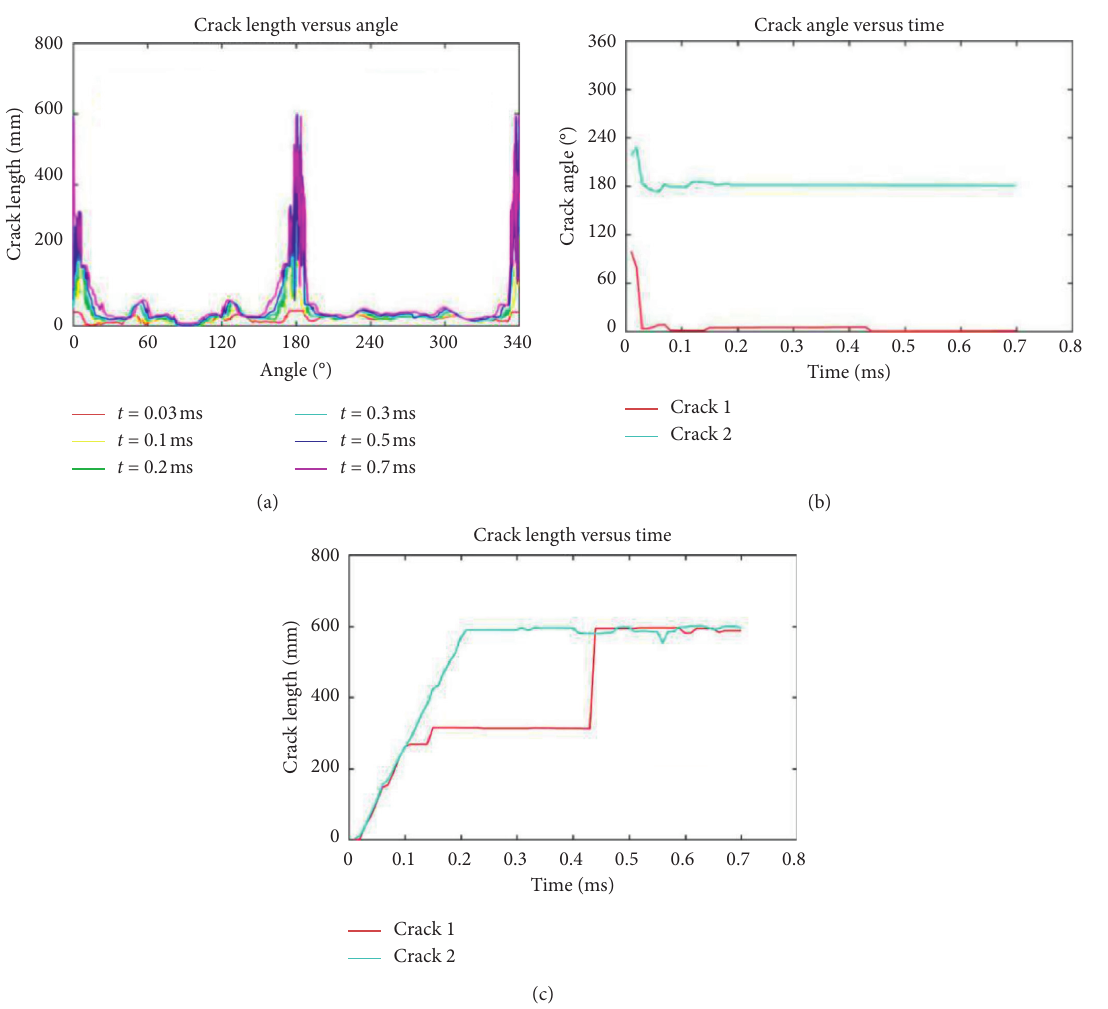
Figure 11: Schematic diagram of 24 ° shaped energy blasting crack. (a) Crack angle versus crack length for 24 ° shaped energy angle. (b) Time evaluation of crack angle for 24 ° shaped energy angle. (c) Time evaluation of crack length for 24 ° shaped energy